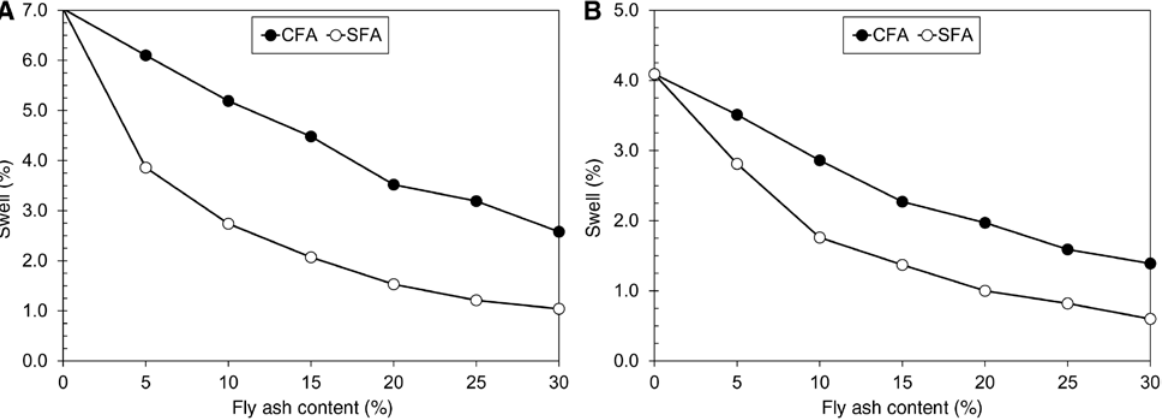
Figure 8: Effect of fly ash on swell percentage (A) Soil A-fly ash mixtures and (B) Soil B-fly ash mixtures.